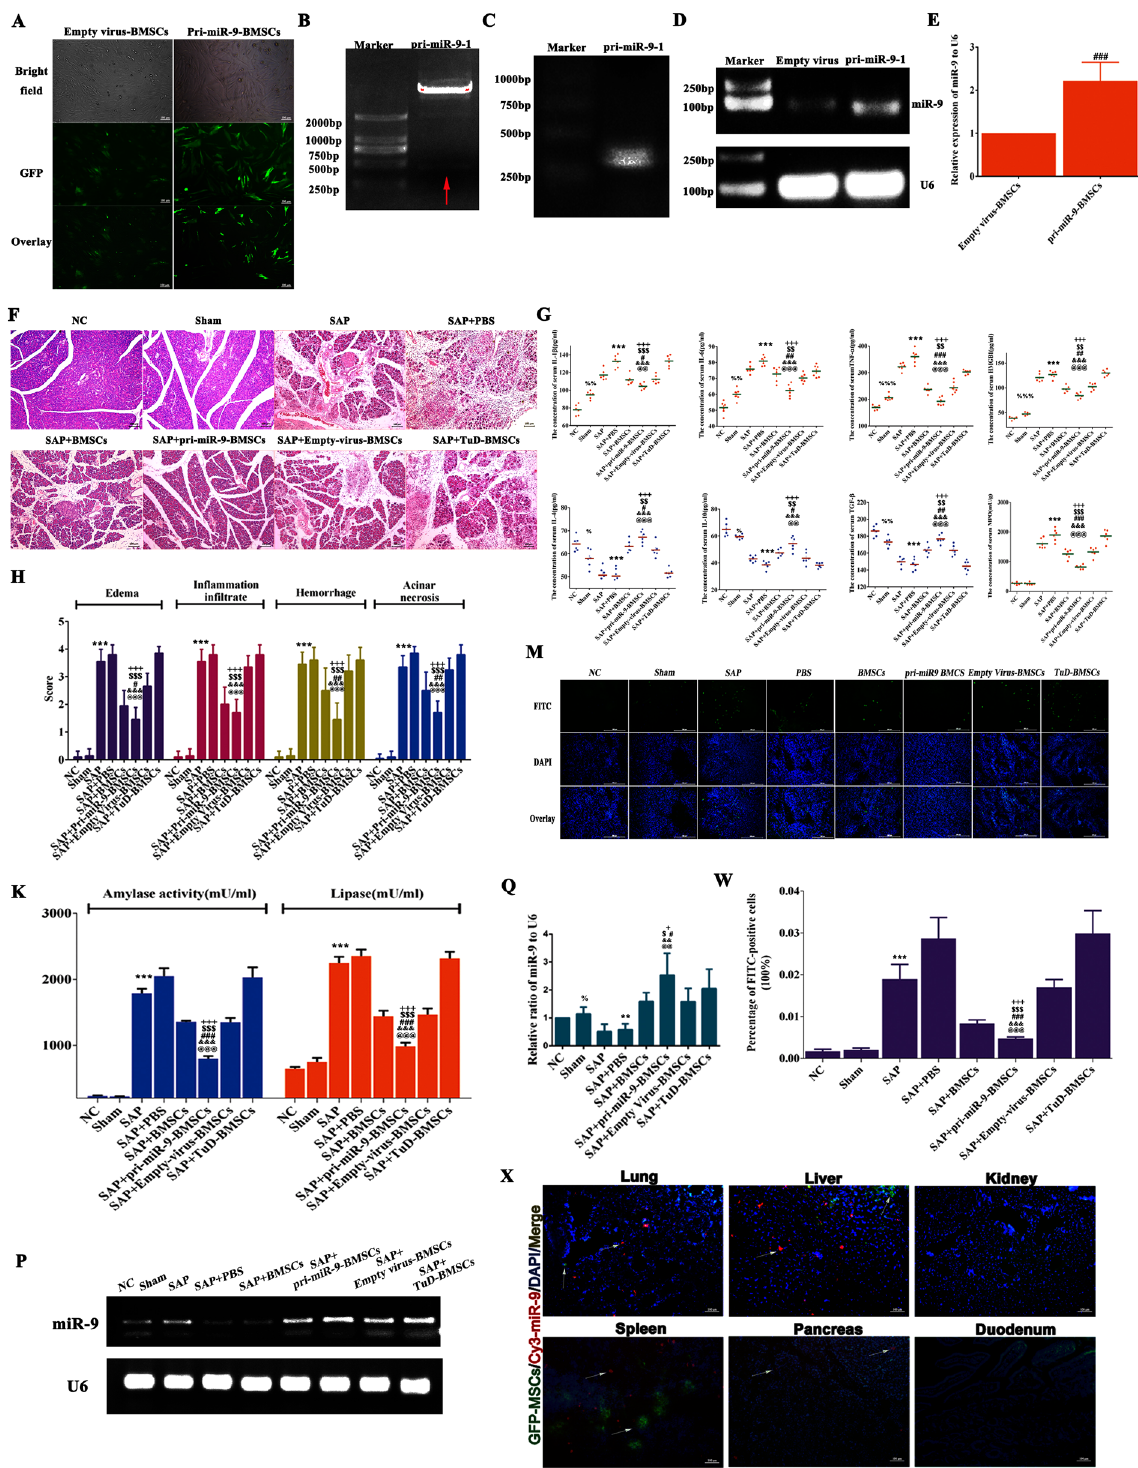
Figure 1. pri-miR-9-BMSCs could attenuate SAP. (A) BMSCs infected by pri-miR-9- and Empty- virus were expressing the Green Fluorescent Protein (GFP). (B) The identification of recombinant pri-miR-9-1-PCDH- CMV-MSCs-EF1-GFP-T2A-Puro plasmid (pri-miR-9-1-PCDH) by double enzyme digestion and a 368 bp DNA fragment (pri-miR-9-1) was shown as red arrow. (C) pri-miR-9-1 was amplified from pri-miR-9-1-PCDH by applying the special primers. (D and E) The expression of mature miR-9 in pri-miR-9-BMSCs was higher than that in Empty virus-BMSCs by gPCR and qRT-PCR. Data are shown as mean ± SD for at least 3 separate experiments. ### p < 0.001, compared with Empty virus-BMSCs by paired t test. (F,H,K,G) pri-miR-9-BMSCs could markedly reduce the pancreatic edema, infiltration, hemorrhage and necrosis, decrease the levels of serum amylase, lipase and pro-inflammatory cytokines (IL-1 β , IL-6, TNF- α , HMBG1, and MPO) and increase